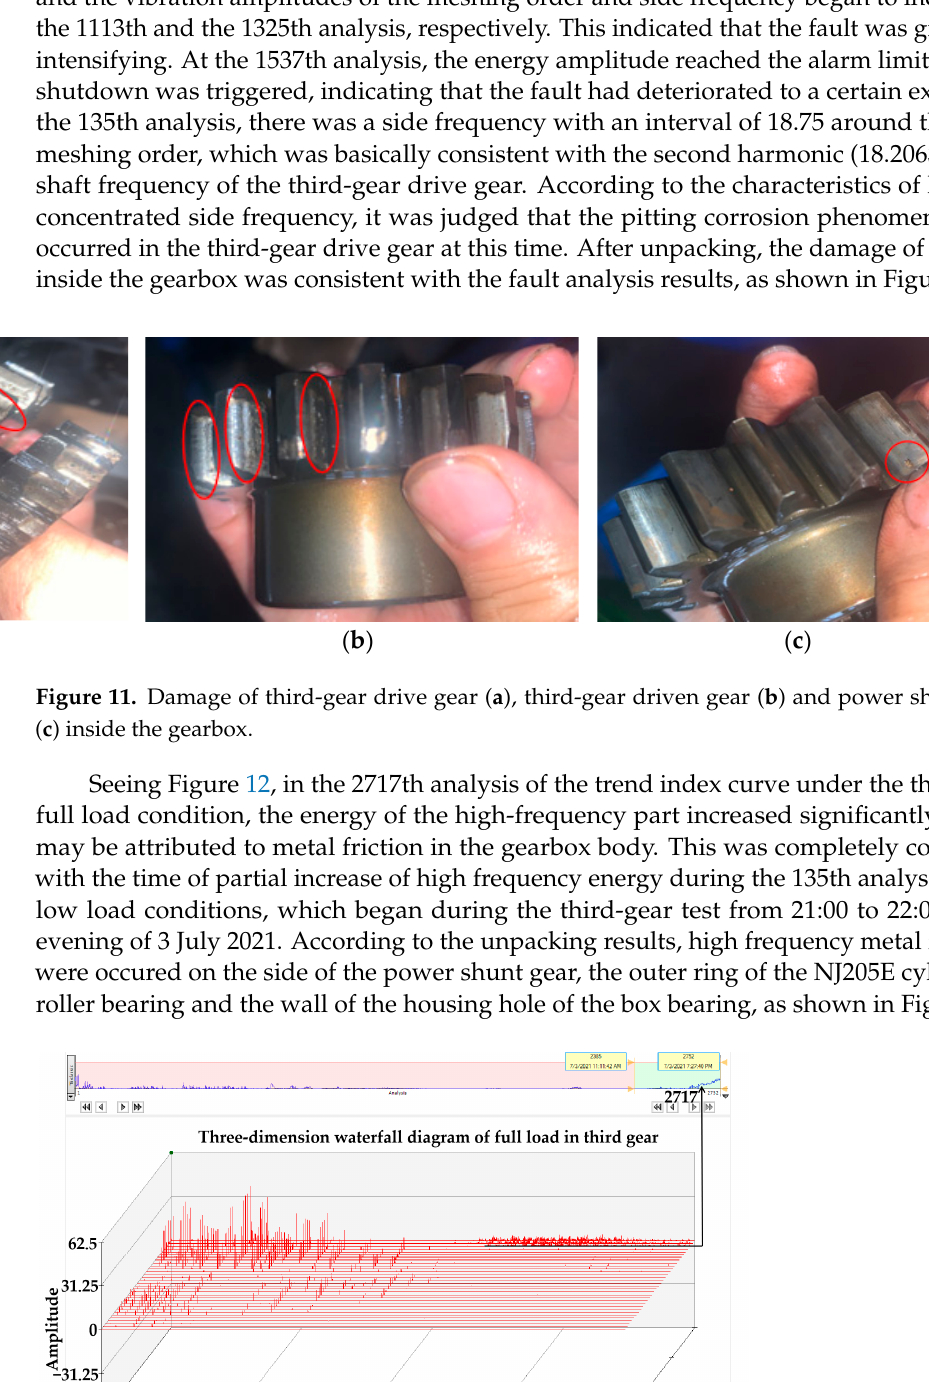
( c ) Figure 13. Internal damages of power shunt gear side ( a ), NJ205E cylinder roller bearing ( b ) and bearing hole wall ( c ). 3.3. Second Gear Fault Analysis As shown in Figure 14, with the small increase in the energy of the low-frequency part in varying degrees, the trend index curve indicating the change of mechanical vibra- tion characteristics in the gearbox began to rise slowly. This indicated that there was some kind of fault in the internal mechanical structure of the gearbox. A side frequency band with an interval of 45 appeared around the 235th order, which was exactly the same as the fourth harmonic of the shaft frequency of the second driven gear. According to the characteristic that the band order of this side was small and concentrated, it was judged that the pitting distributed fault may occur in the second driven gear. This fault can also be observed in the 3D waterfall diagram of the second gear full load, as shown in Figure 15, and the fault occurred at the same time. The gear damage after unpacking can be seen in Figure 16. This was basically consistent with the results of fault analysis. ( a )